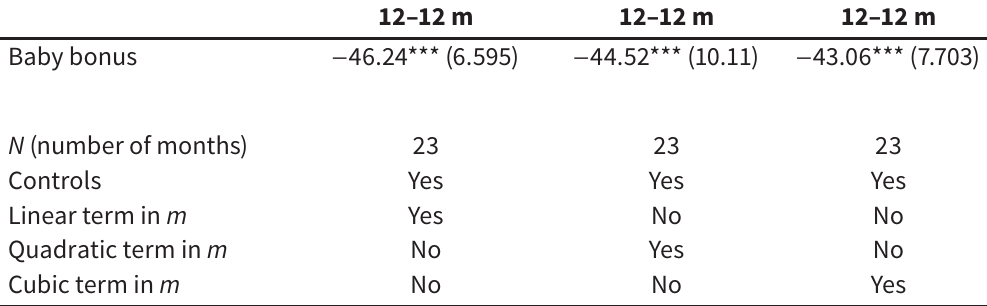
Baby Bonus receipt